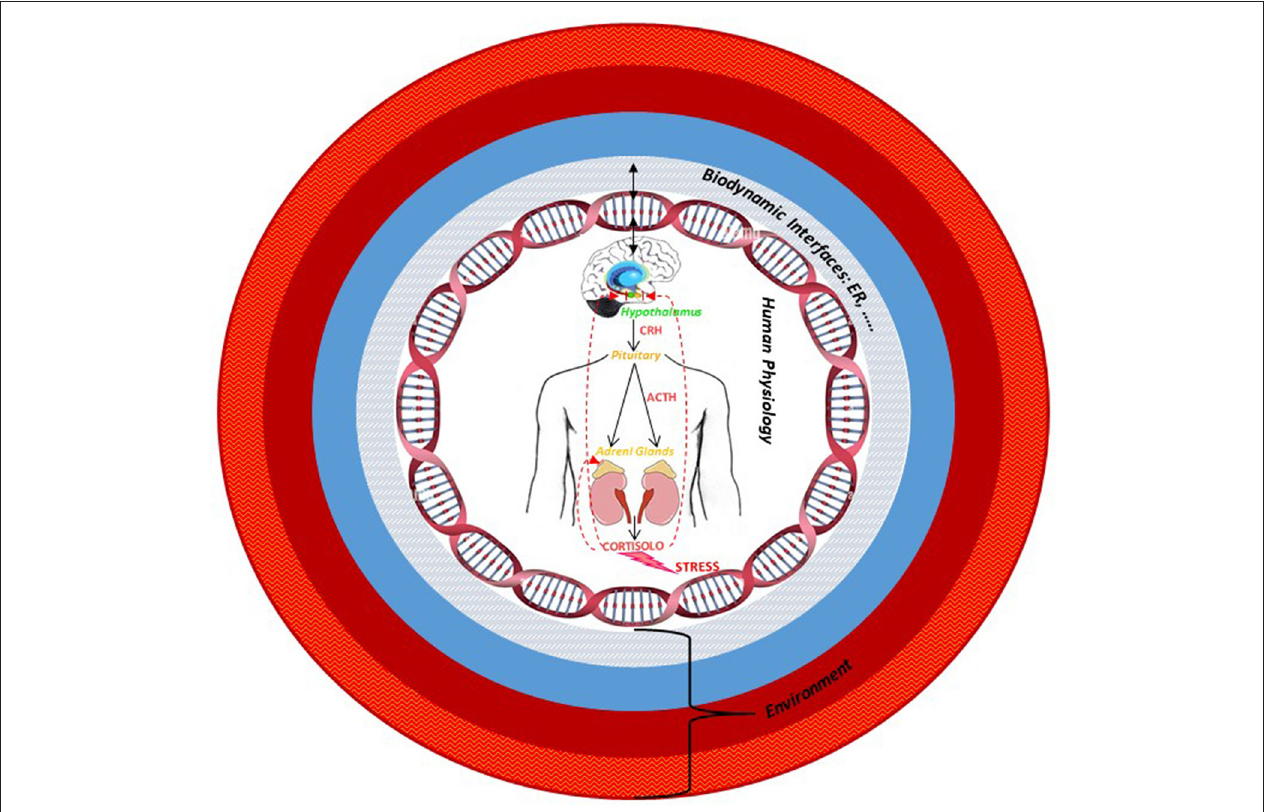
FIGURE 5 | The multiple levels organization of human being–environment system: The estrogen receptor, as an example of biodynamic interface, modulates the interaction among external socio-environmental stressors, the body, and the consequent behavioral changes. The arrows indicate the bidirectional and dynamic interaction between the organism and the environment via the